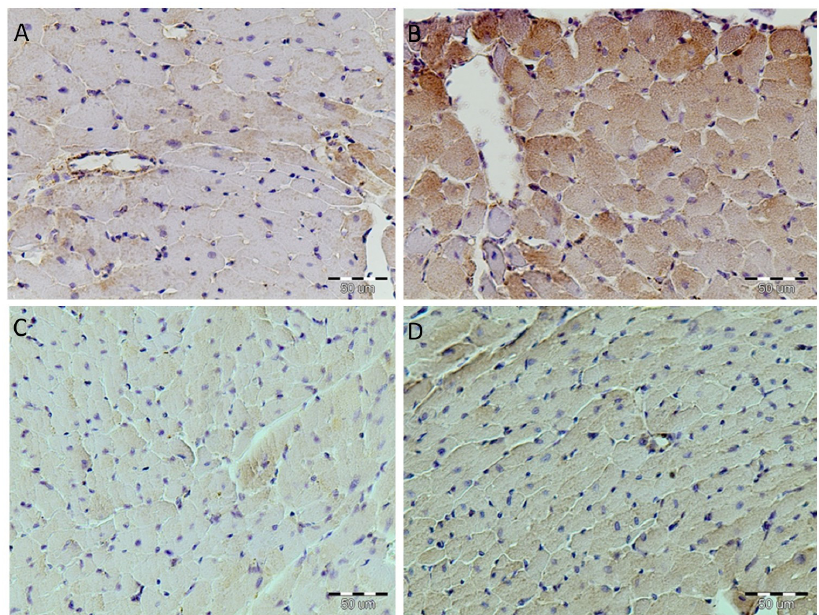
Figure 7. Resveratrol attenuated Bax expression in the heart tissue of the essential and malignant hypertensive rats. The expression of Bax in heart tissue was examined by immunohistochemical staining, magnification 400×. ( A ) The relative number of brown stained myocytes in SHR group, ( B ) expression significantly increased, determined as intensive brown cytoplasmic staining widely distributed in heart tissue of the MHR, ( C ) negative immunostaining in the SHR + R group, and ( D ) myocytes showed rare immuno-positive cells in MHR + R. In the SHR + R group, some myocytes showed positive Bcl-2 immunoreactivity. Slight positive Bcl-2 immunoreactivity was seen in myocytes of SHR and MHR + R. There